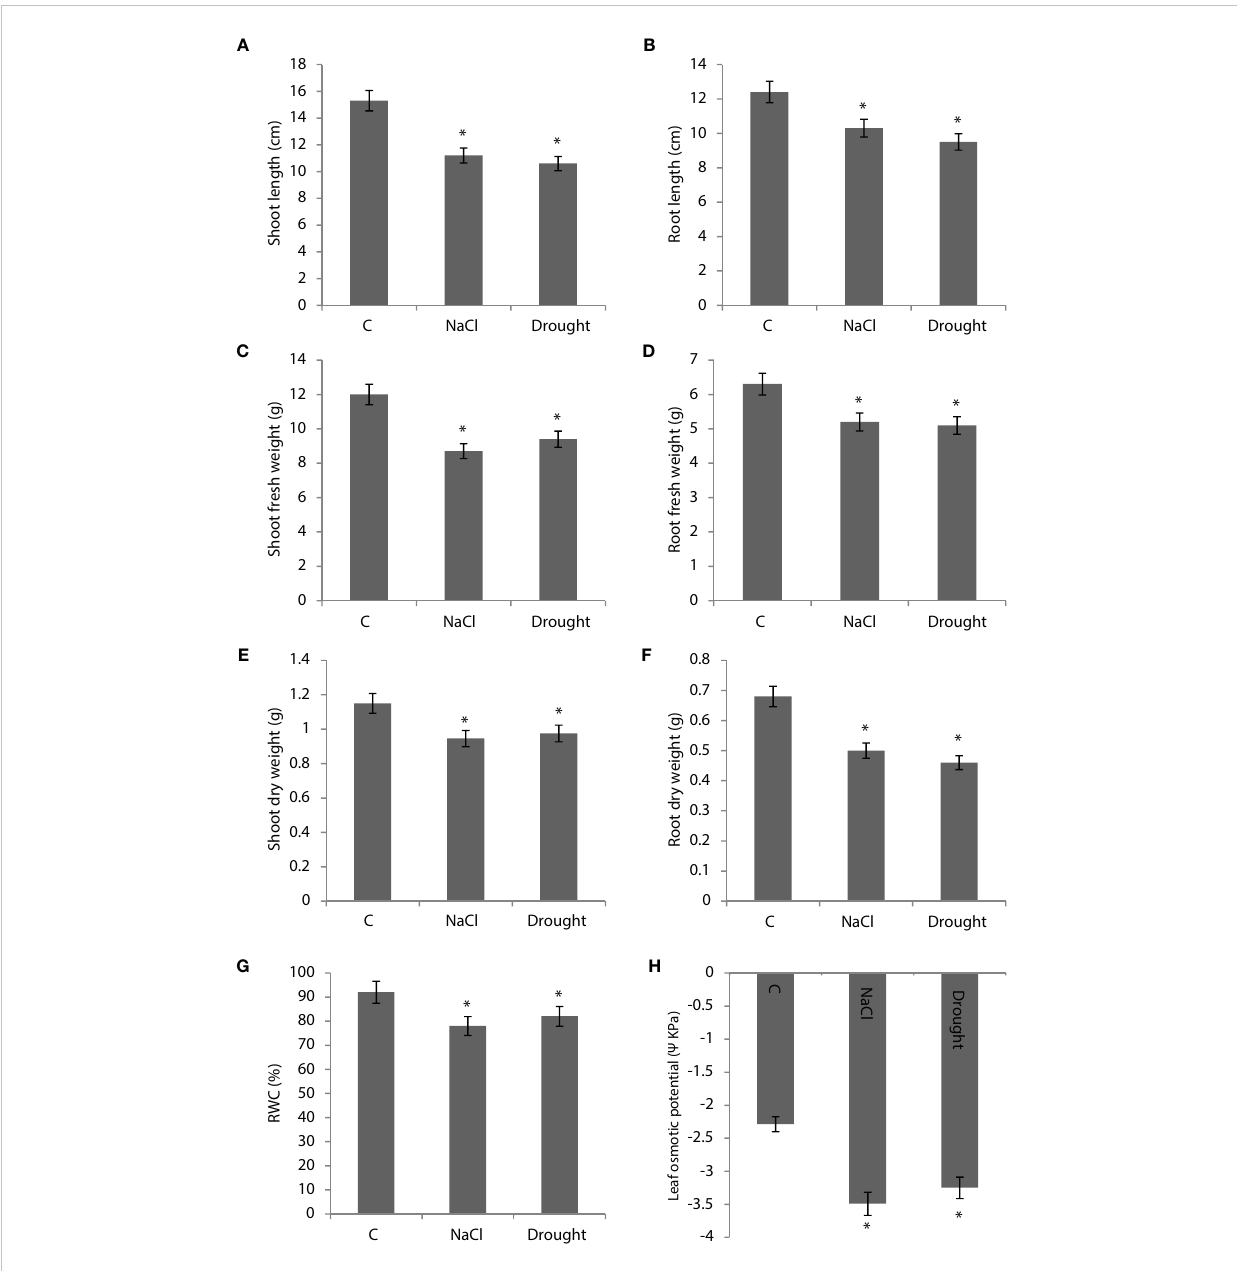
FIGURE 2 (A, B) Shoot and root length, (C, D) shoot and root fresh weight, (E, F) shoot and root dry weight, (G) relative water content (RWC) and (H) leaf osmotic potential of Bienertia sinuspersici plants treated with 400 mM NaCl or water withholding for 10 d. “ * ” indicates signi fi cant difference (p < 0.05) as compared to